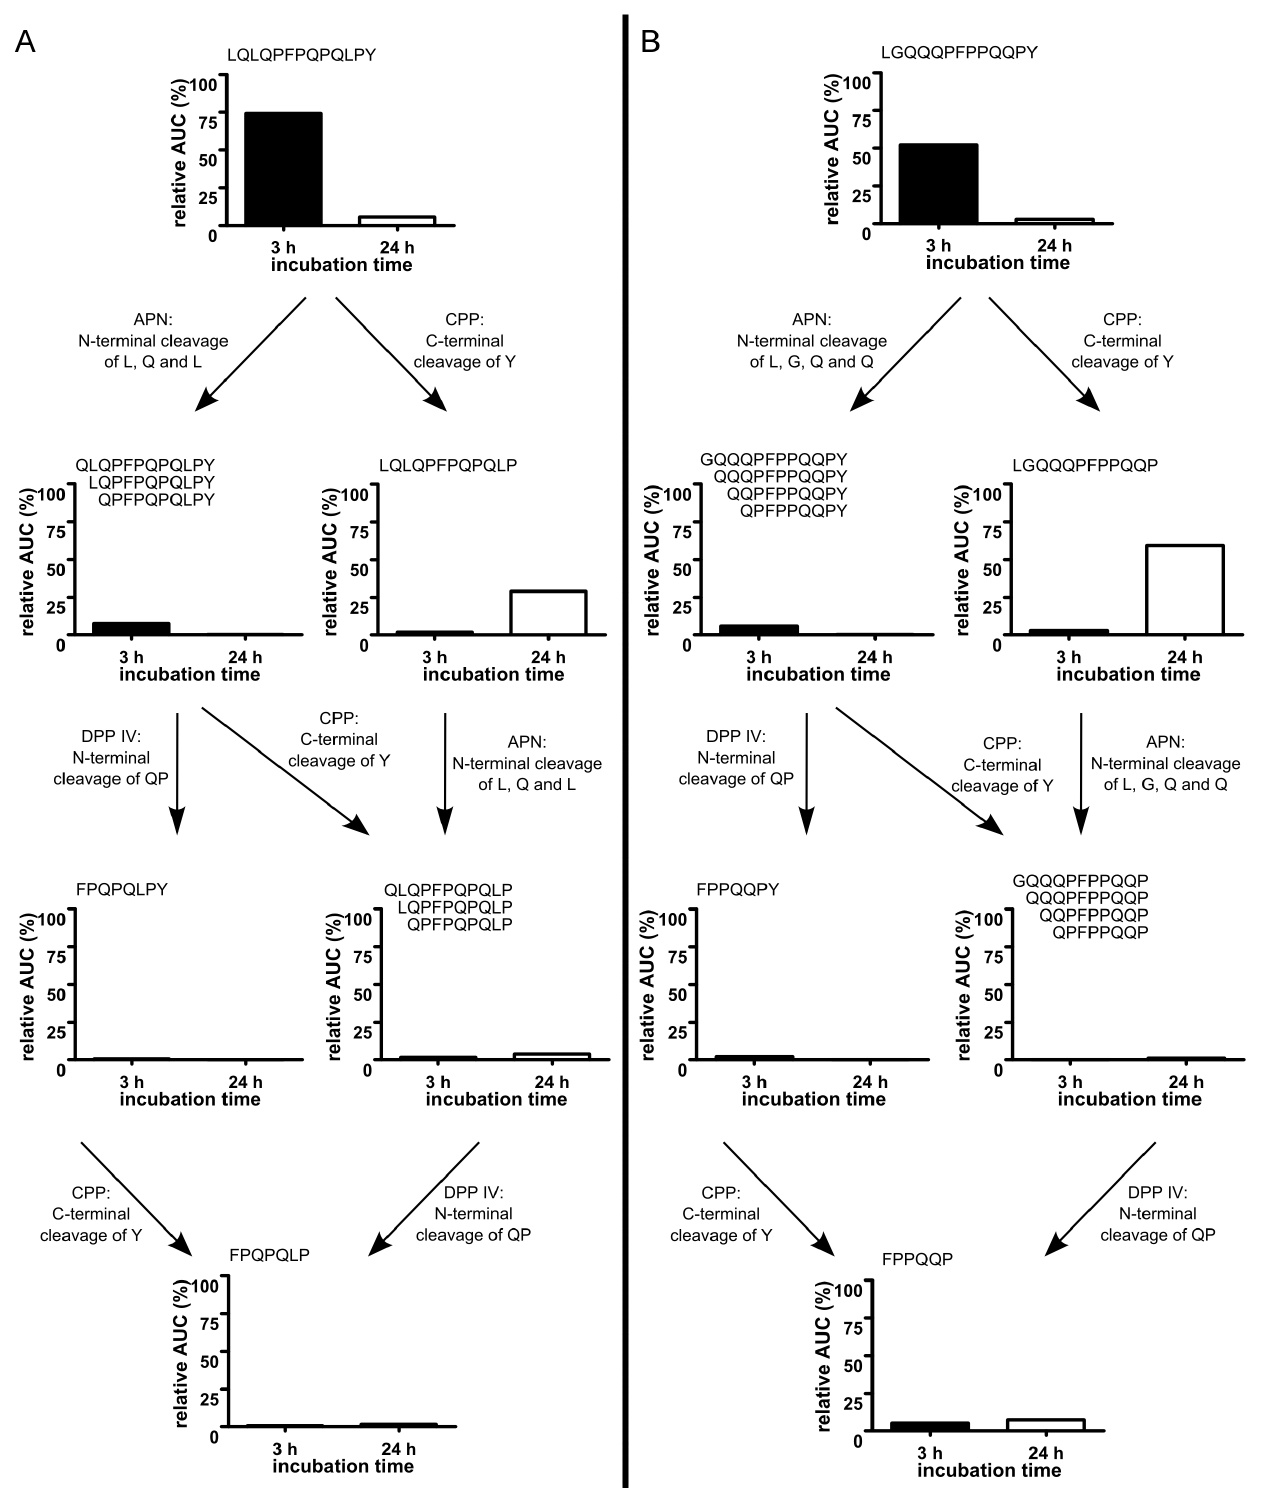
Figure 4. Digestion of P56–68 and P31–43 by Caco–2 cells. MALDI–TOF–MS analysis of digestion products of P56–68 (LQLQPFPQPQLPY) (A) and P31–43 (LGQQQPFPPQQPY) (B) on the apical side of Caco–2 monolayers. The degradation pathway was reconstructed considering the membrane peptidases APN, CPP and DPP